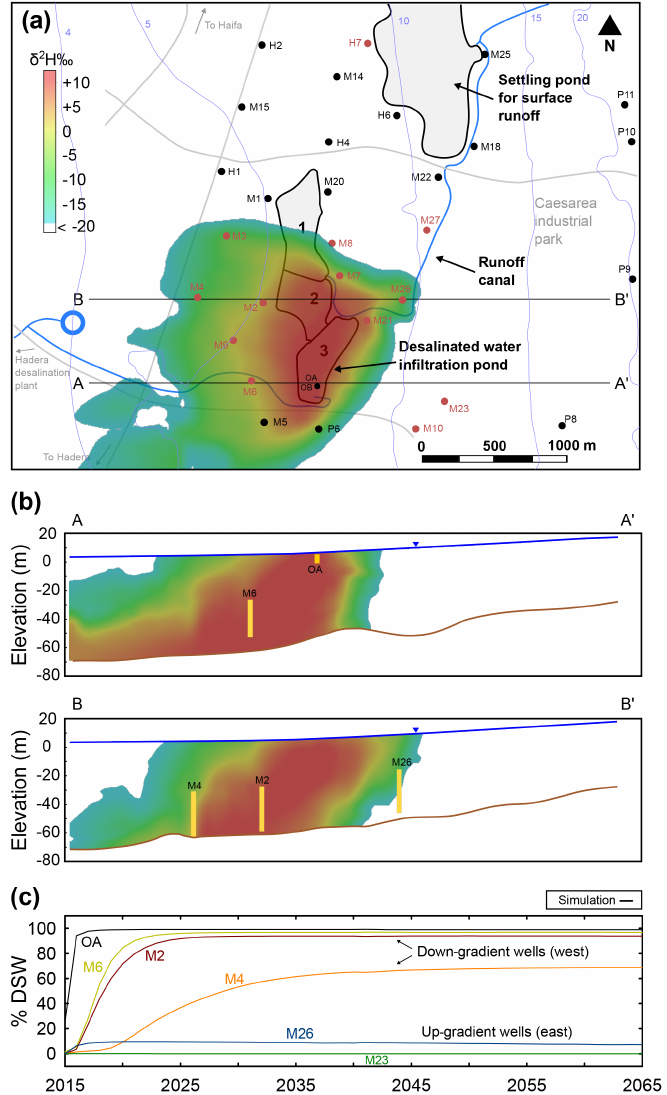
Figure 7. Long-term simulations of DSW spreading at the end of 2065 after 50 years of MAR. (a) Plan view (water table); the colored area shows the DSW plume, the white area indicates natural GW ( δ 2 H< − 20‰) and the blue contours are the GW head. (b) East–west cross sections through wells OA and M6 (A-A (cid:48) ) and wells M4, M2 and M26 (B-B (cid:48) ); well screens are shown in yellow. (c) Simulated DSW fraction (%) in selected wells along the cross sections A-A (cid:48) and B-B (cid:48)